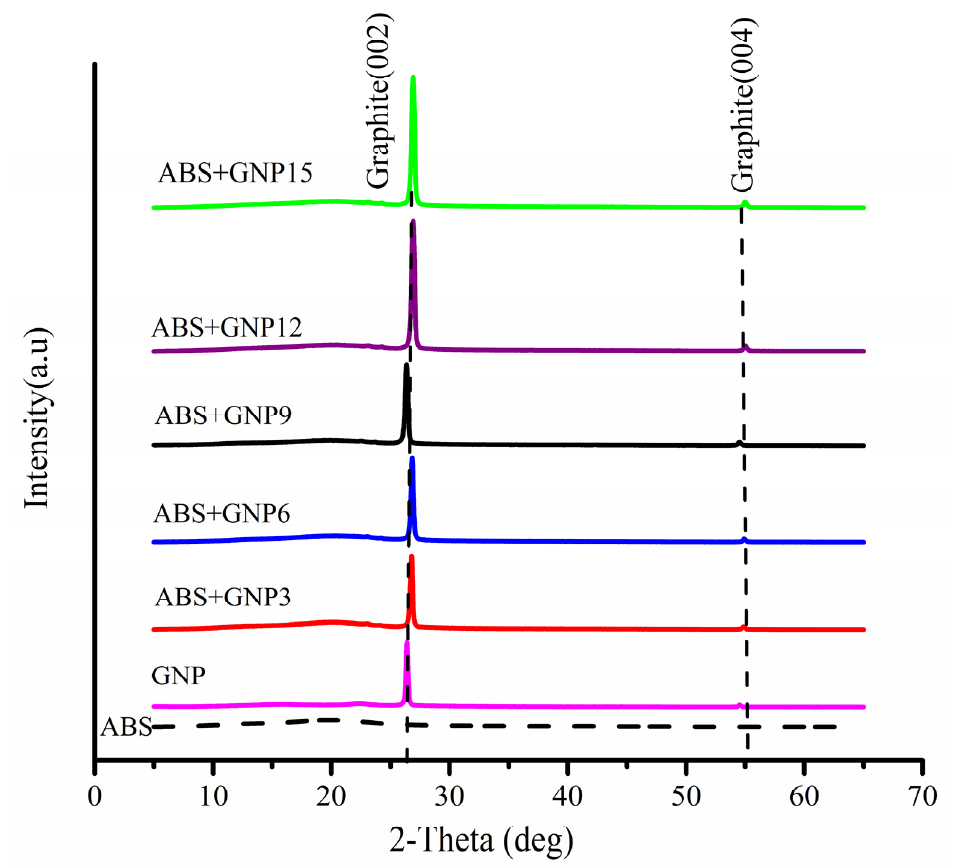
Figure 3. XRD spectrums of GNP, neat ABS, and ABS+GNP